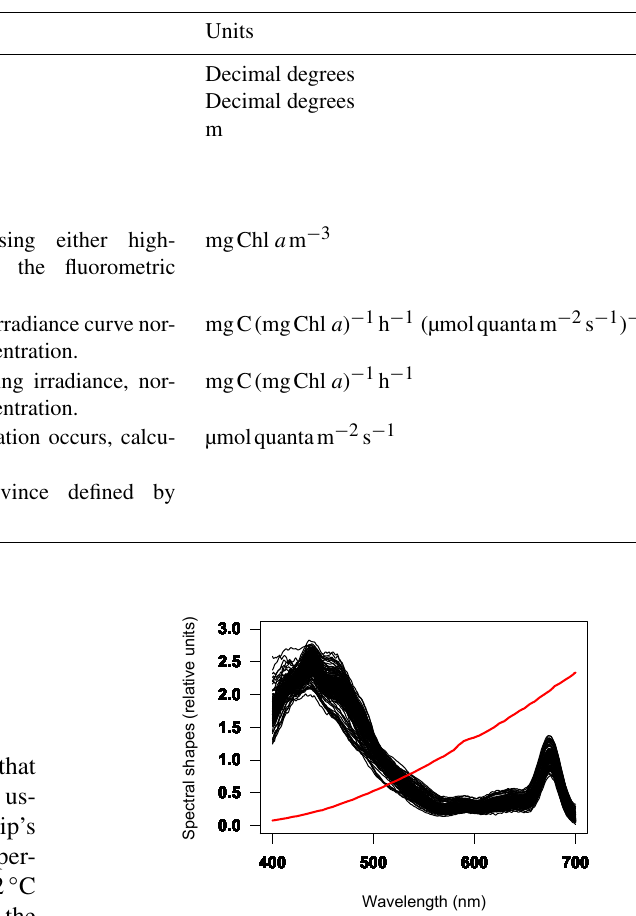
Table 3. List of environmental variables and P - E parameters in the MAPPS database and their corresponding units.